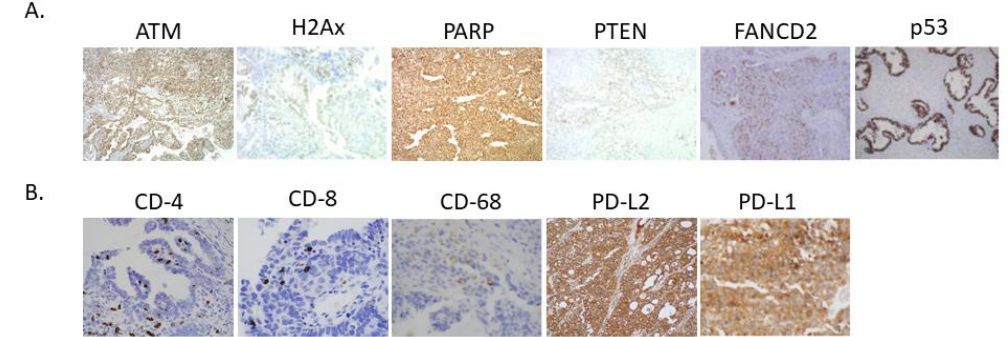
Figure 1. Expression of DNA repair and immune checkpoint markers in epithelial ovarian tumors. Representative immunohistochemistry staining of ( A ) DNA repair (ATM, H2Ax, PARP, PTEN, FANCD2, and p53) and ( B ) immune markers (CD-4, CD-8, CD-68, PD-L2 ,and PD-L1) in a tissue microarray with clinically annotated ovarian tumor tissue. Table 3. Correlation analysis for biomarkers.